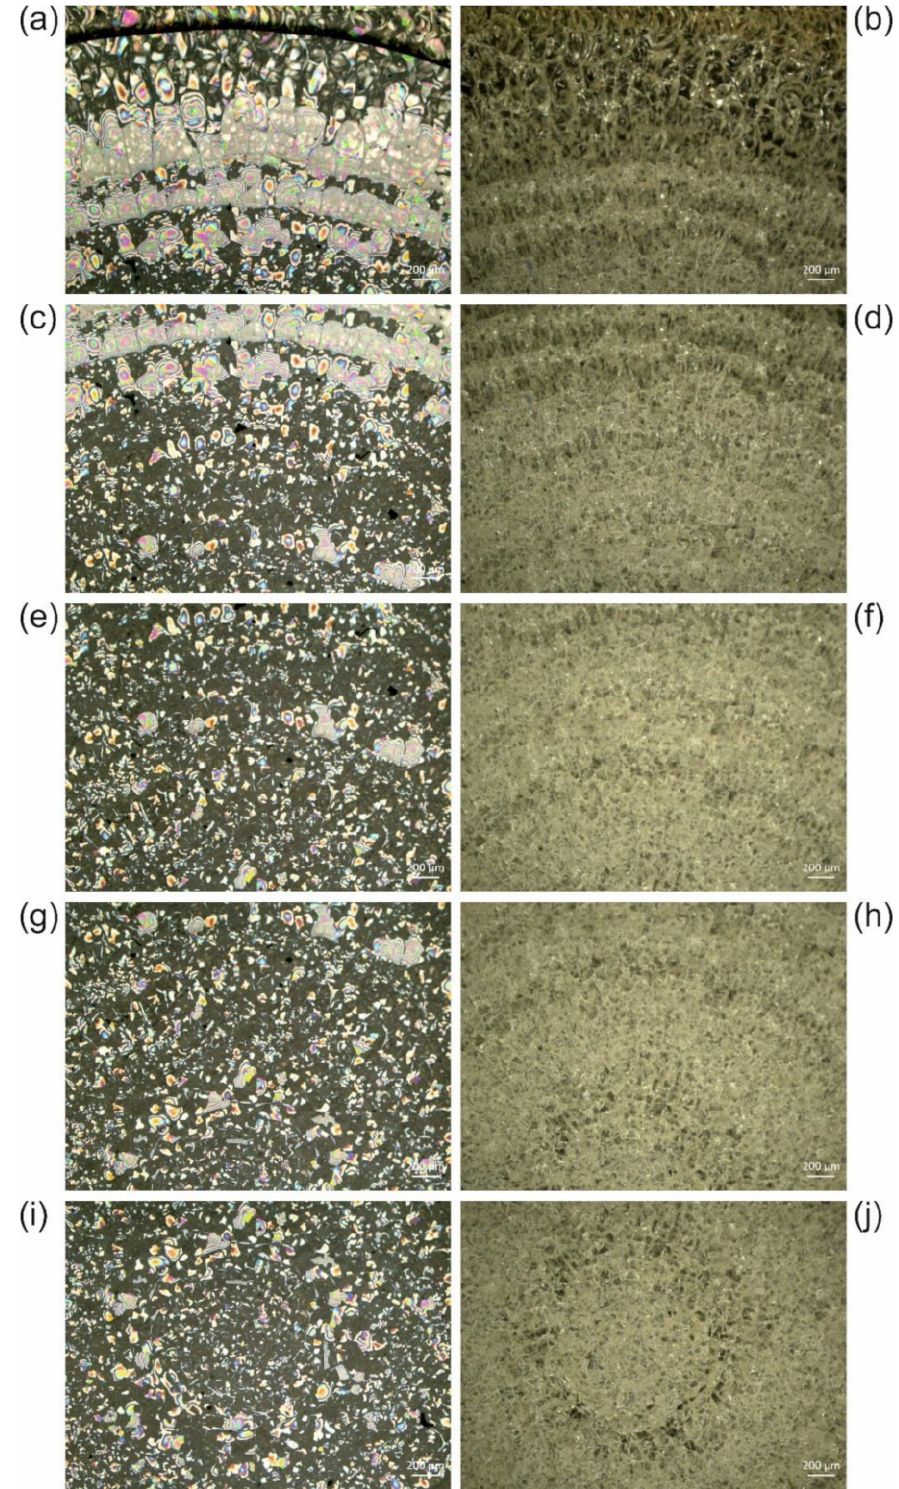
Figure 8. ( a , c , e , g , i ) Reflected light brightfield and ( b , d , f , h , j ) reflected light darkfield micrographs of sample USNM 1226524, Cateria gerlachi , in Permount TM , from the edge of the cover slip ( a , b ) towards the centre ( i , j ), showing cracks in concentric rings almost completely connected to each other. Due to high optical density, transmitted light images were not